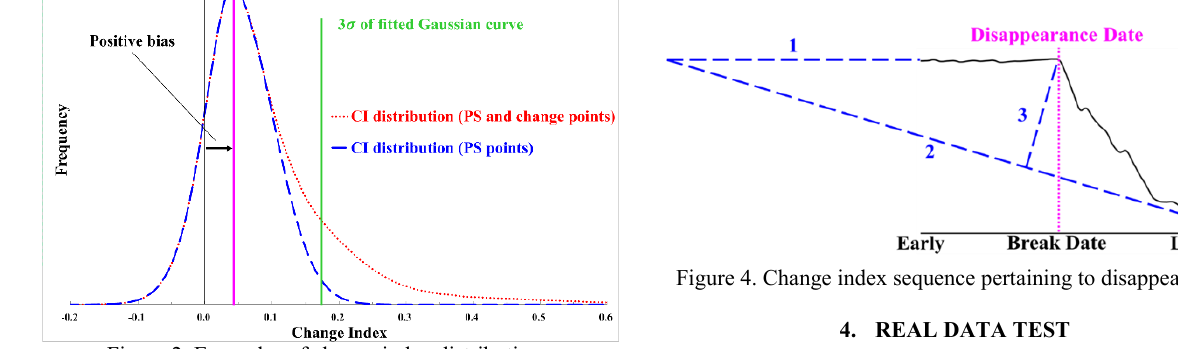
Figure 2. Examples of change index distributions.